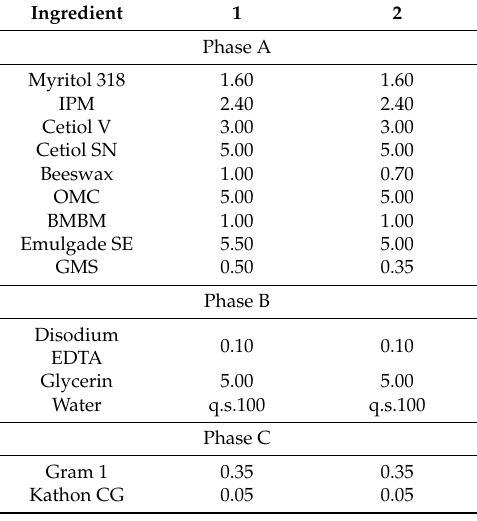
Table 1. Composition (% w / w ) of oil in water (O/W) emulsions 1 and 2. IPM: isopropyl myristate; OMC: octylmethoxycinnamate; BMBM: butylmethoxydibenzoylmethane; GMS: glyceryl monostearate. Ingredient